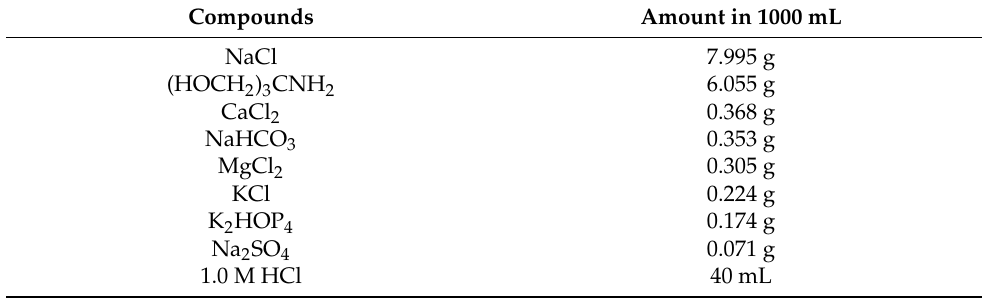
Table 2. Chemical compounds of simulated body fluid (SBF)